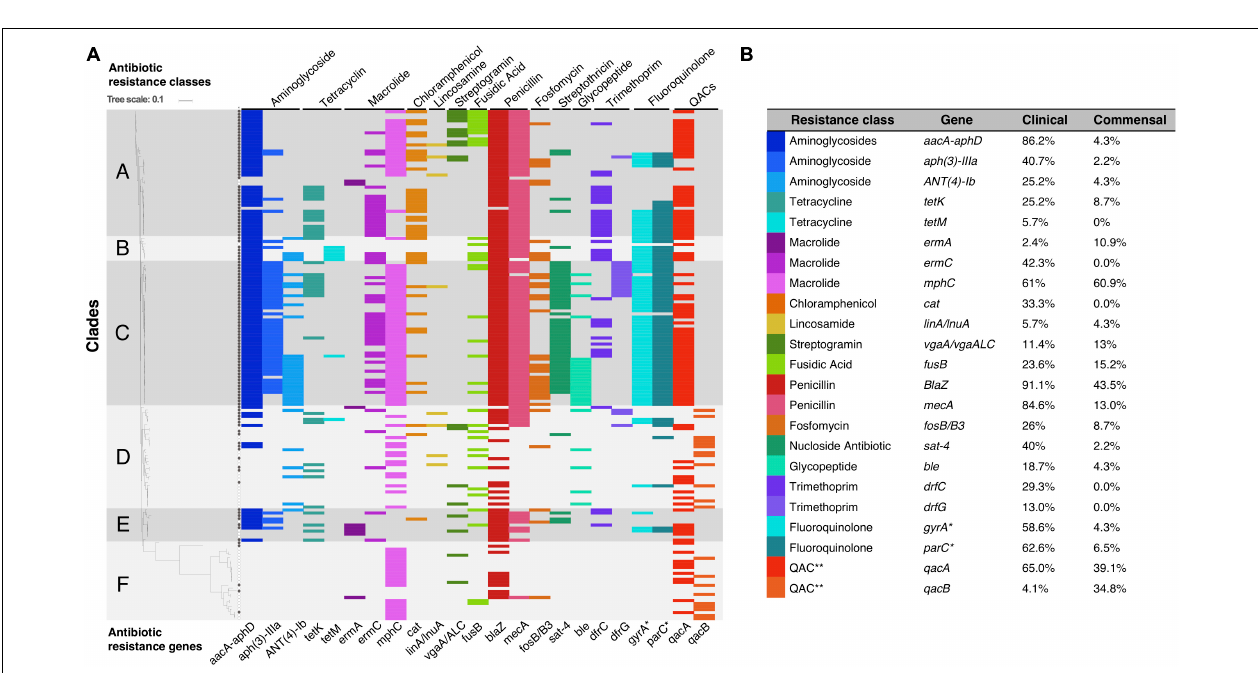
FIGURE 2 | (A) Number and origin of isolates included in this study. (B) Phylogenetic tree of the 169 S. haemolyticus isolates, based on SNPs in the core genome. Each isolate is color coded based on country of origin, as demonstrated in the pie chart. Clinical isolates are displayed as circles and commensal isolates as squares.